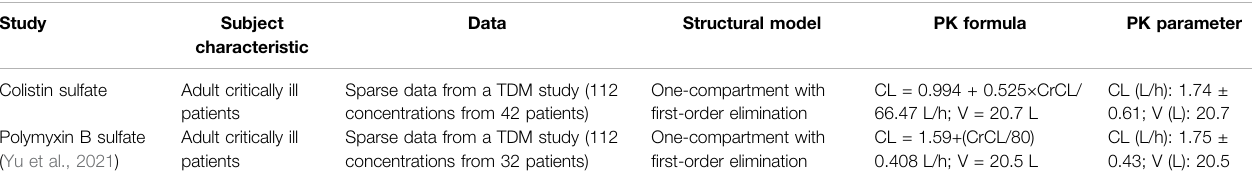
TABLE 4 | Comparison of pharmacokinetic parameters of colistin sulfate with polymyxin B